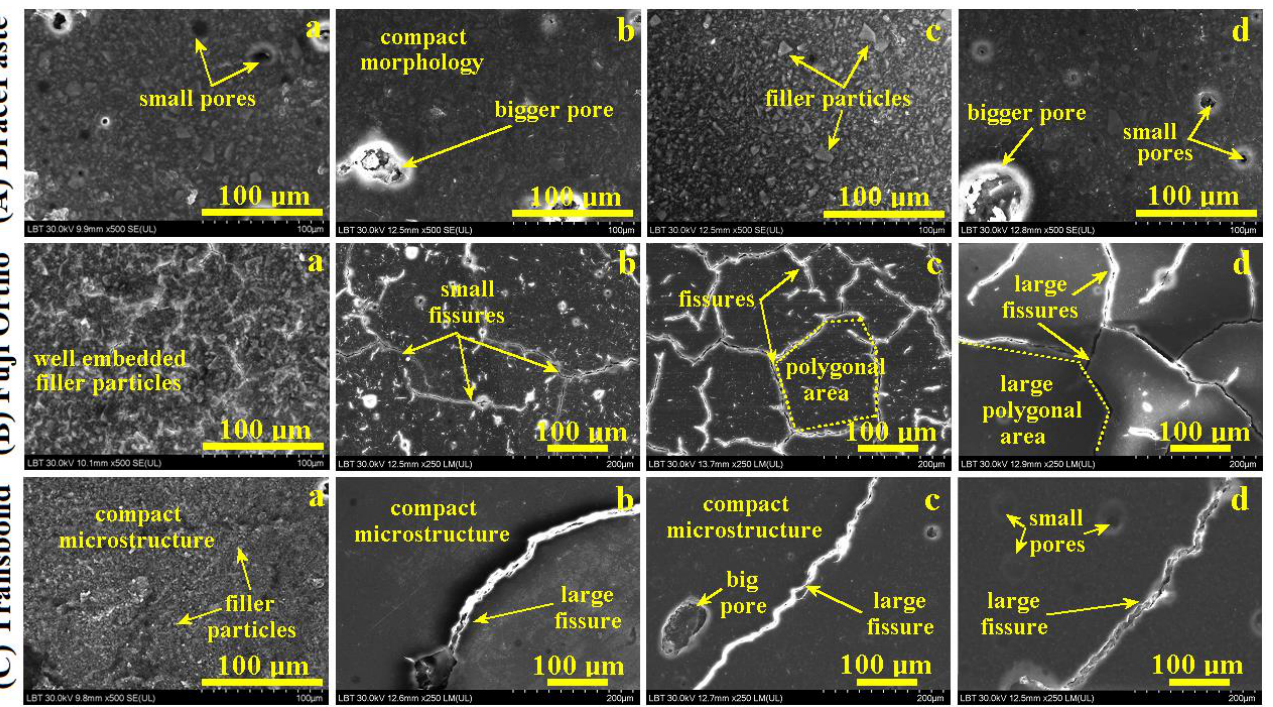
Figure 4. SEM images of the investigated samples: BracePaste ( A ); Fuji Ortho ( B ) and Transbond ( C ) exposed at different liquid environment: ( a ) initial — unexposed, ( b ) artificial saliva, ( c ) Coca- ( C ) exposed at different liquid environment: ( a ) initial—unexposed, ( b ) artificial saliva, ( c ) Coca-Cola Cola and ( d ) Red Bull. and ( d ) Red